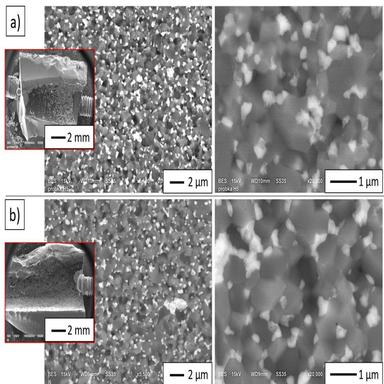
Sample fractographic observations of ZrO2-rich areas: a) Series I - 40 vol.%of solid phase with 10% vol. of ZrO2, b)Series II - 45 vol.%of solid phase with 10% vol. of ZrO2.